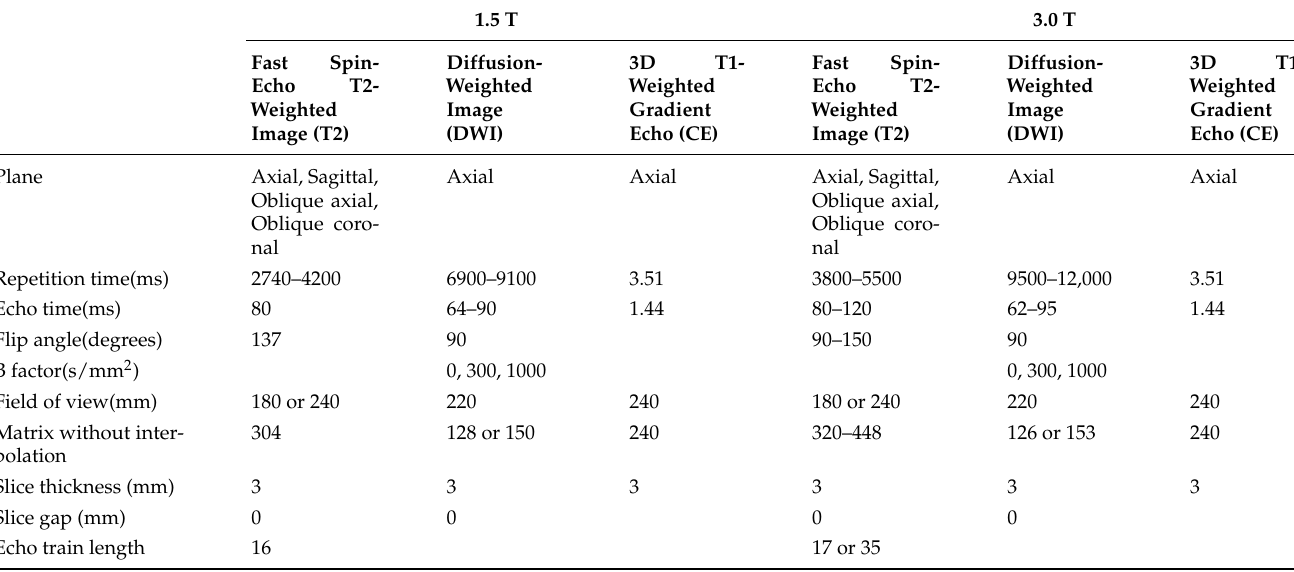
Table A1. The MRI parameters. 1.5 T 3.0